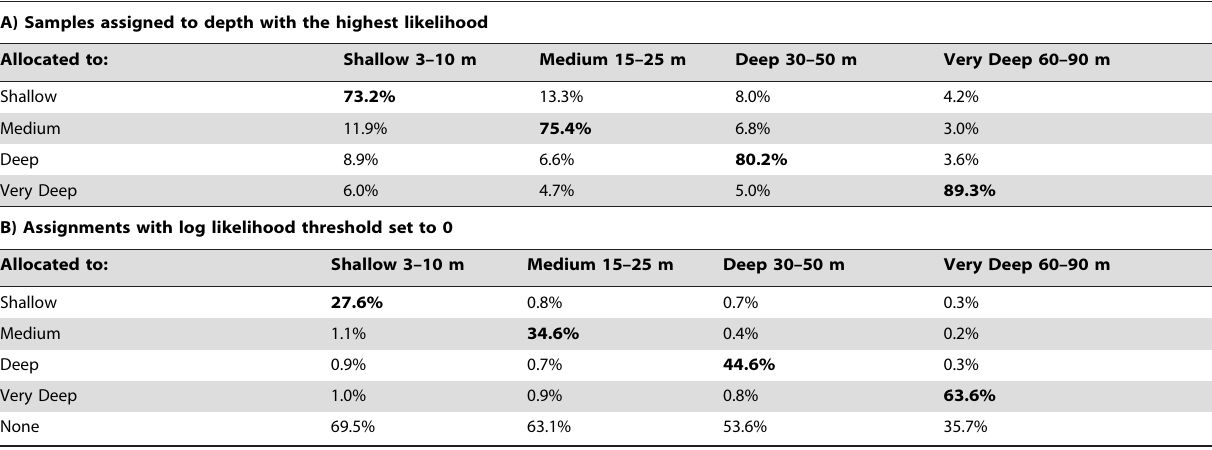
Table 6. Assignment based upon AFLPOP analysis of band frequencies of samples categorized only by depth (LCI, LSI and SS collection sites combined).